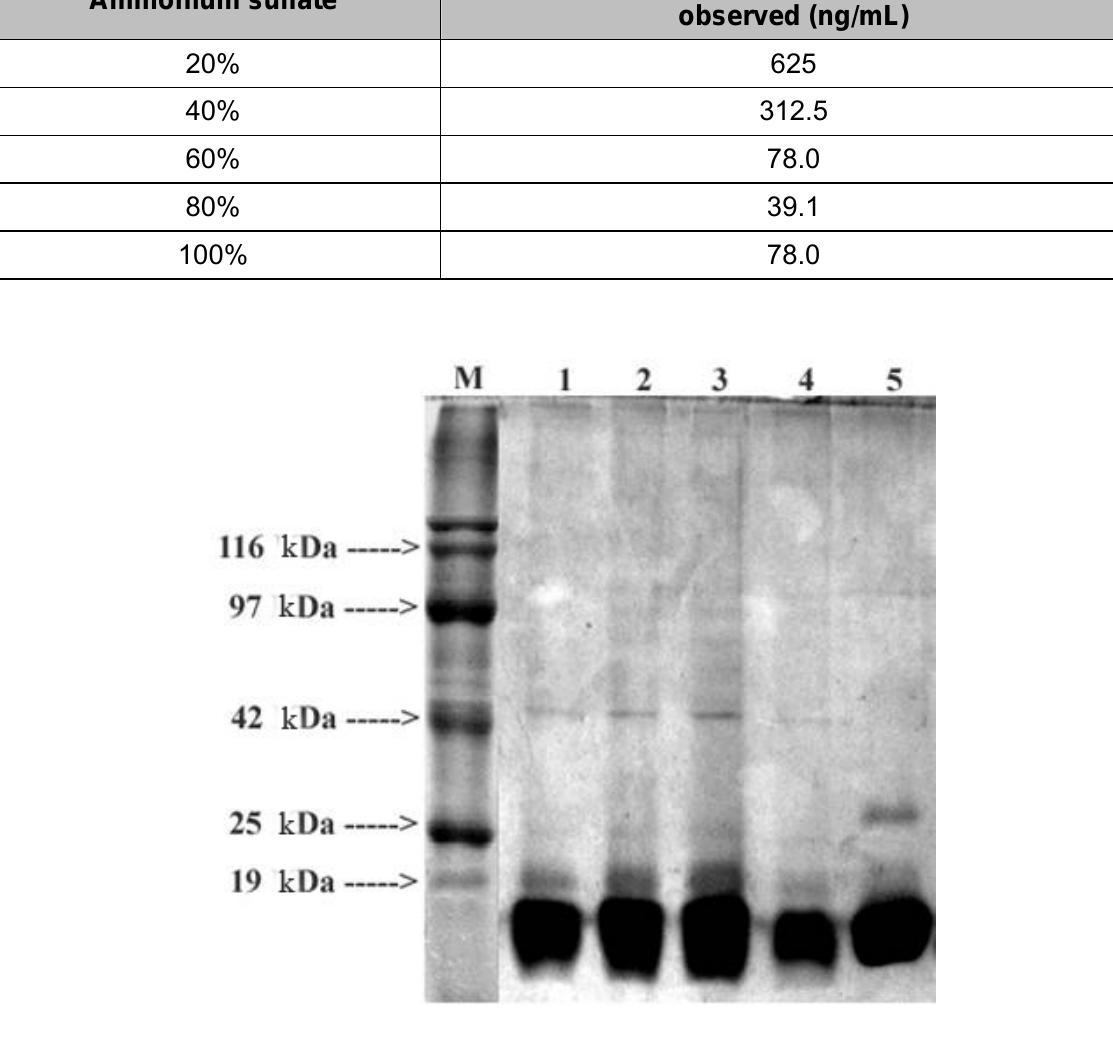
Figure 4 . SDS-PAGE analysis of ammonium sulfate fractions. M: marker, lane 1: 100% ammonium sulfate fraction, lane 2: 80% ammonium sulfate fraction, lane 3: 60% ammonium sulfate fraction, lane 4: 40% ammonium sulfate fraction, and lane 5: 20% ammonium sulfate fraction. The 19-kDa hemolytic toxin was precipitated in all fractions but the quantity and activity peaked only in particular fractions (60 to